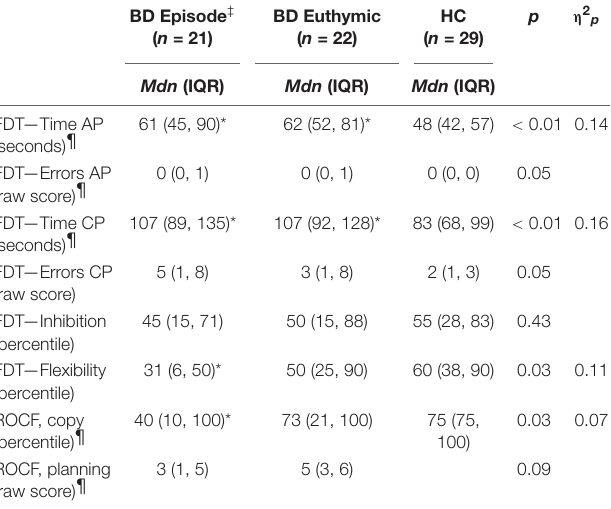
TABLE 3 | Performance of the groups for five digit test and Rey–Osterrieth complex